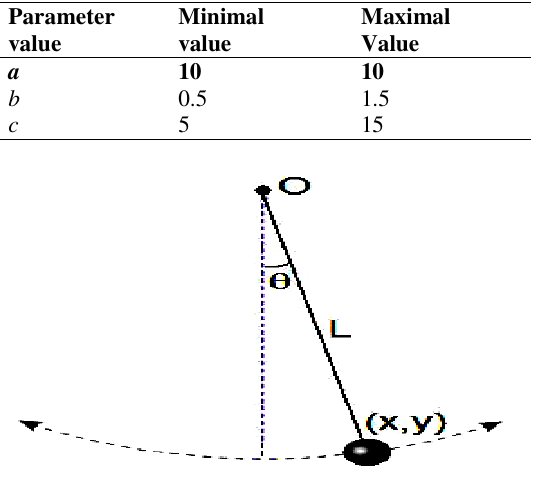
Fig. 6. The simple pendulum